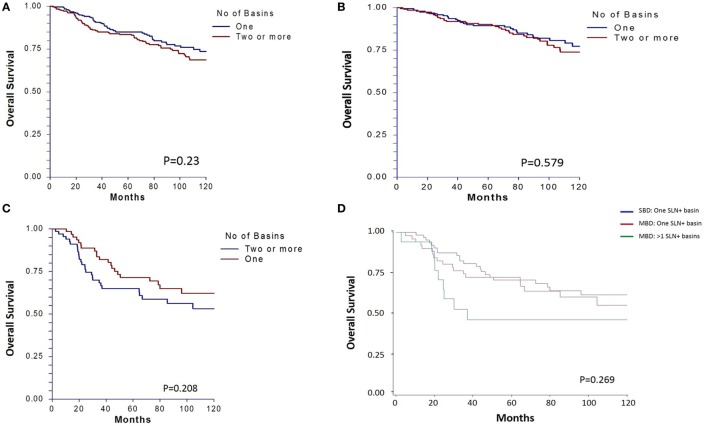
(A) Ten-year overall survival for matched patients who had single basin drainage (SBD) and multibasin drainage (MBD). Survival is also shown for (B) matched subgroups with tumor-negative sentinel lymph nodes (SLNs) and (C) tumor-positive SLNs. (D) Survival for SLN-positive patients is further categorized by single basin versus multibasin metastases.